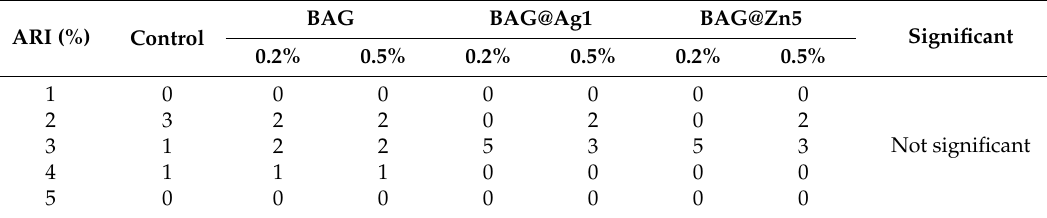
Table 1. Adhesive Remnant Index (ARI) scores of orthodontic bonding agents